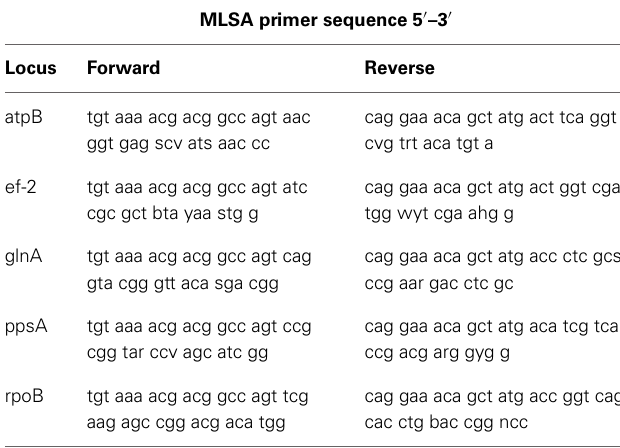
Table 1 | Degenerate primers used to PCR amplify and sequence the genes for MLSA.